Question: Sum up the contents of this chart in one sentence.
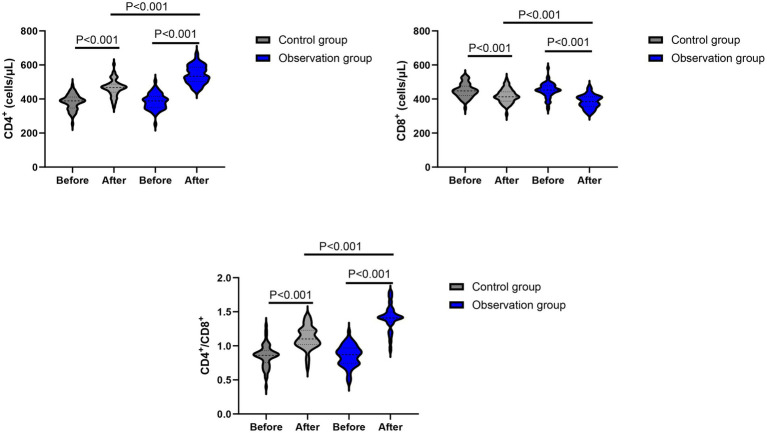
Answer: Immune-function indicators before and after treatment in the two groups. CD4+ and CD8+ T-cell counts are presented as mean ± standard deviation; the CD4+/CD8+ ratio is presented as median (interquartile range).